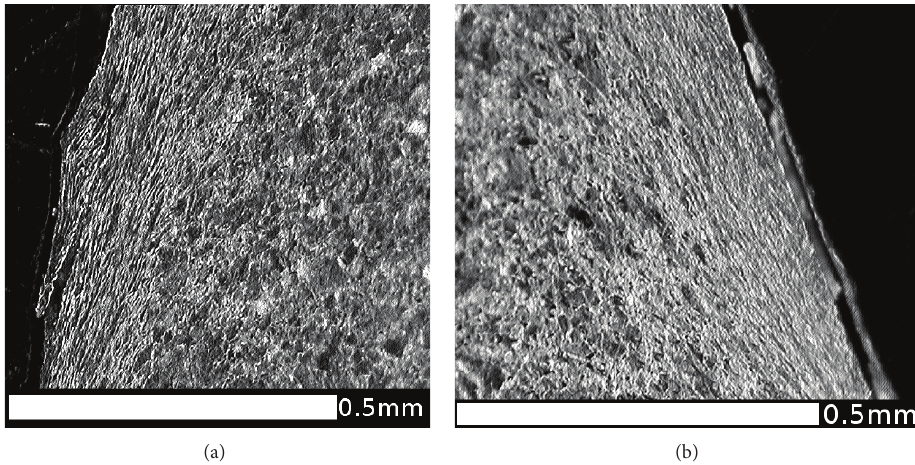
Figure 12: OM images of microstructure: (a) flange back (FB) and (b) flange face (B); These regions experience rubbing contacts with checkrails or the outer running rail on sharp curves. The predominant direction of the shear forces is circumferential (normal to the cross section in the figure), and the microstructure is affected to a depth of approximately 0.2 mm.